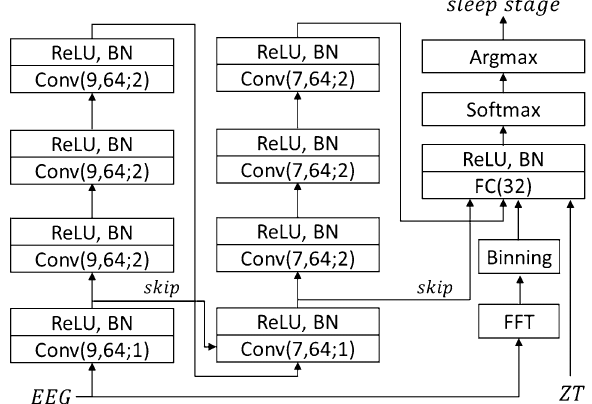
Figure 1. Network structure of the UTSN. Conv( a , b ; c ) indicates a block consisting of a one-dimensional convolution layer with kernel size a having b channels and stride set to c . FC( d ) is a block composed of a fully connected layer having d output channels. FFT, Fast Fourier Transformation; skip, skip-connection; ReLU, rectified linear unit; BN, batch